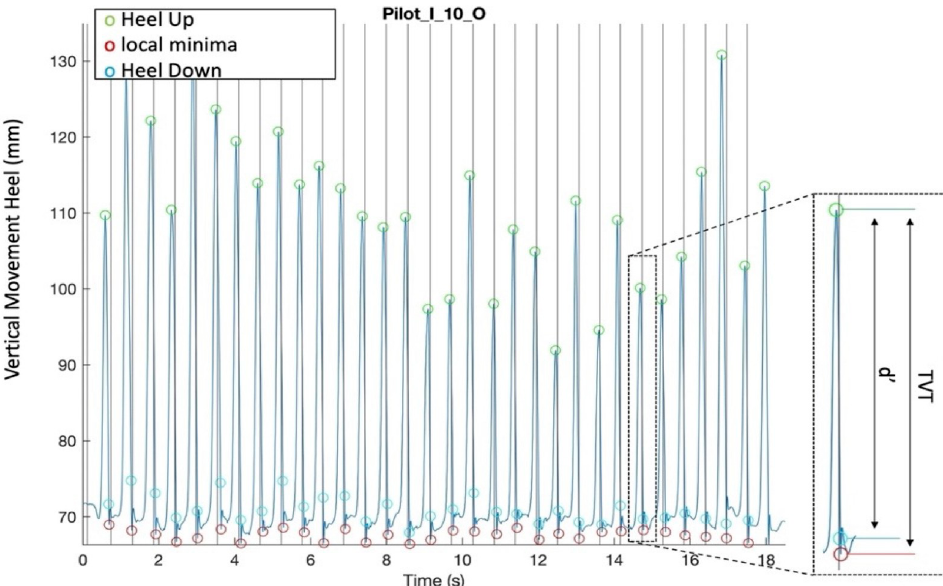
Fig 3. The vertical movement of the left heel during a dance fragment. The local maxima (green circles) are onset data (Heel Up). The local minima (red circles) show a little bounce, so the first time point where the marker is recorded at > 90% (D’) of its total vertical trajectory (TVT) between a local maximum and its subsequent minimum (light blue circles) is considered as the second set of onsets (Heel Down). The black vertical lines indicate the musical beats during the dance